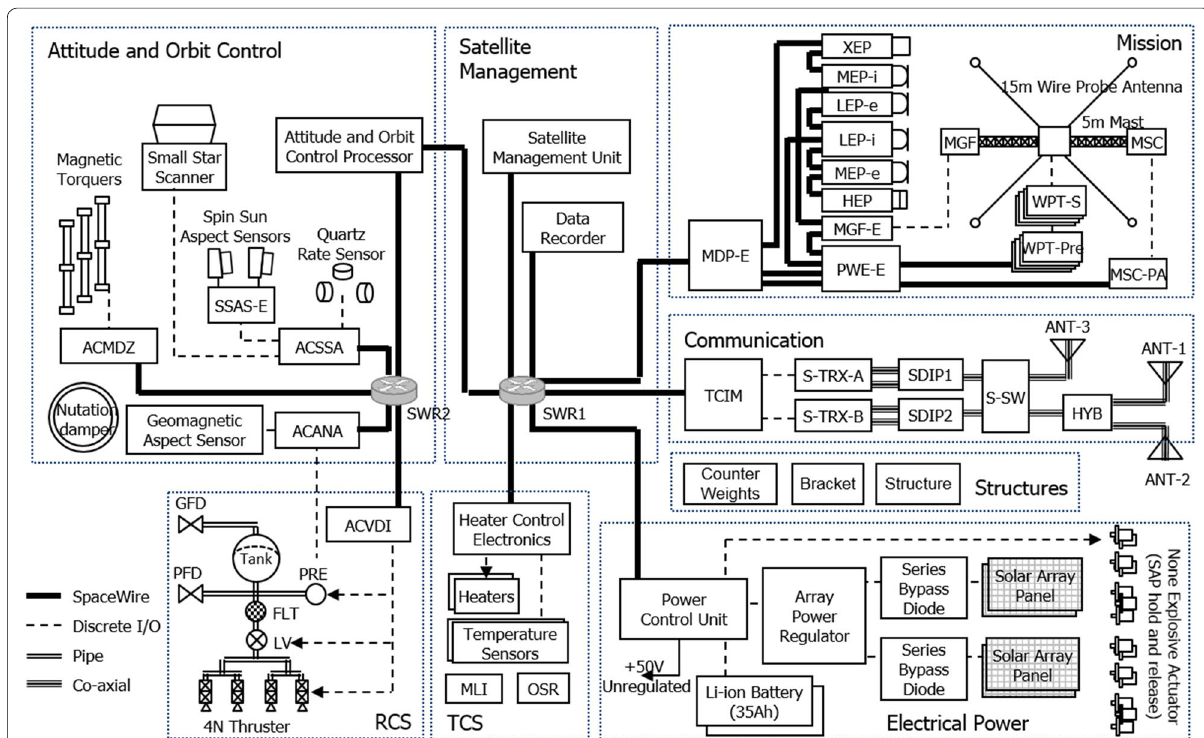
Fig. 2 The block diagram of Arase spacecraft bus and mission systems. The bus network has two different SpaceWire networks—one is the data communication, network connected to the SpaceWire router (SWR-1), and the other is the AOCS network, connected to the SWR-2. The mission network in the upper right side connects to the SWR-1 via MDP-E. Each instrument in the mission part is not connected to the bus network directly. (This block diagram is taken from Figure 4 of Nakamura et al.